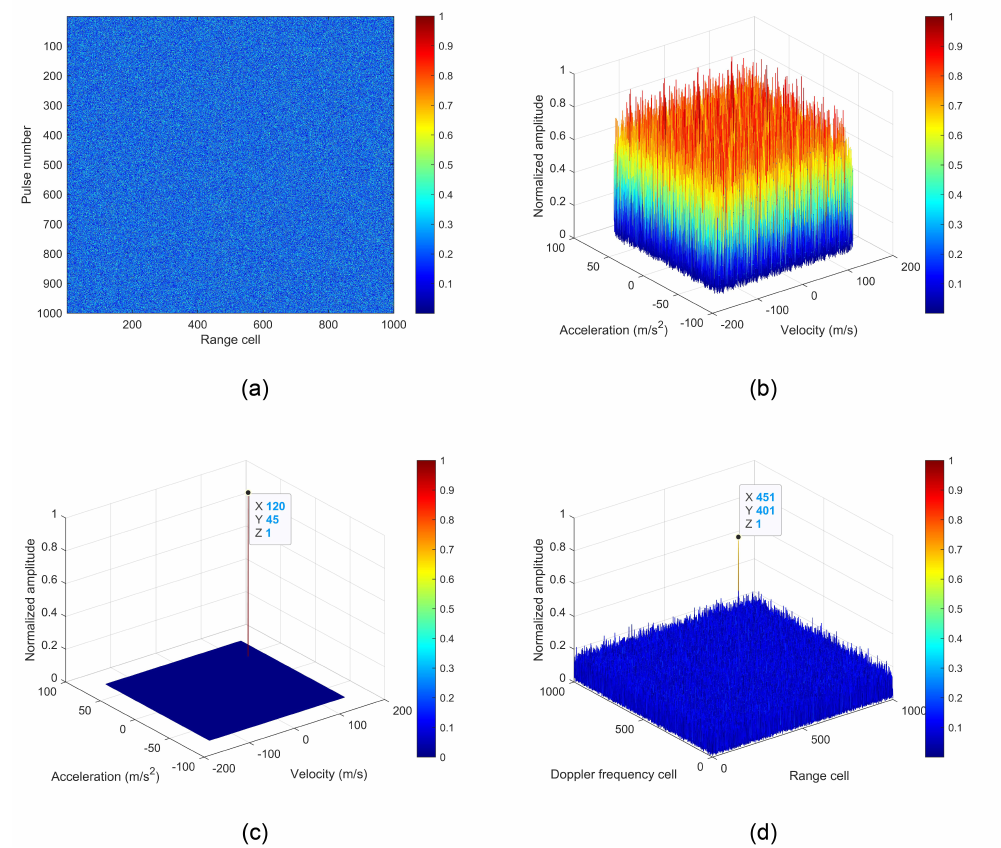
Figure 8. The role of product operation in a low SNR environment ( a ) The result of PC. ( b ) The result of SZDCFT at f = 0 MHz. ( c ) The result of PSZDCFT. ( d ) The result of coherent